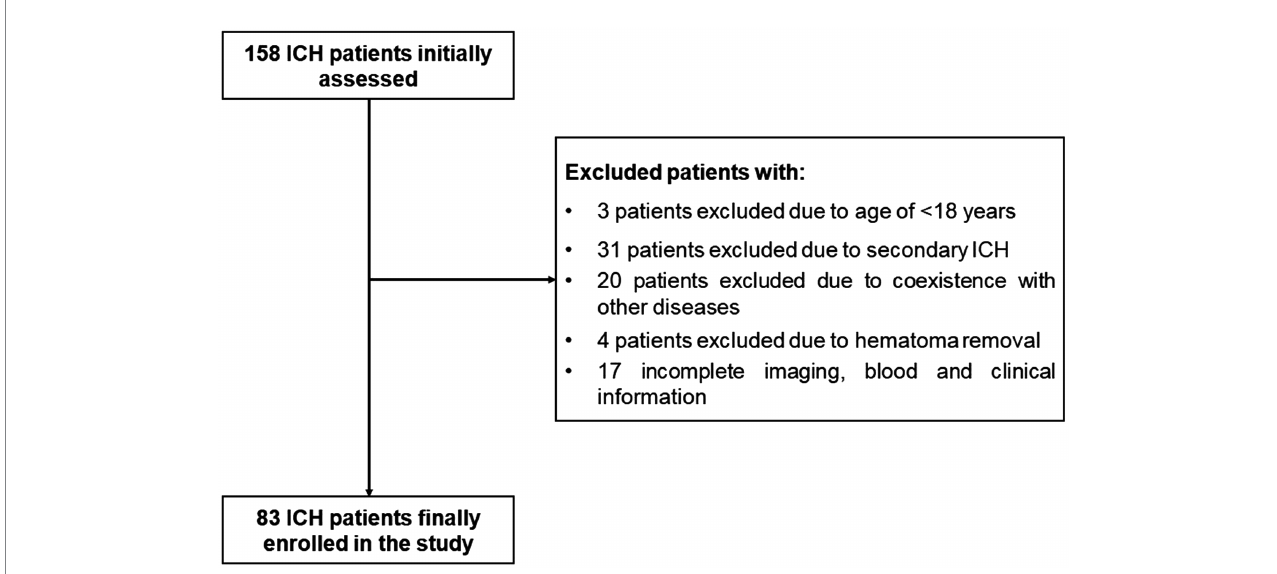
FIGURE 1 The flowchart for screening eligible patients with acute spontaneous ICH. Initially, 158 ICH patients were assessed; thereafter, we excluded 75 patients; and ultimately, 83 ICH patients were enrolled. ICH indicates intracerebral